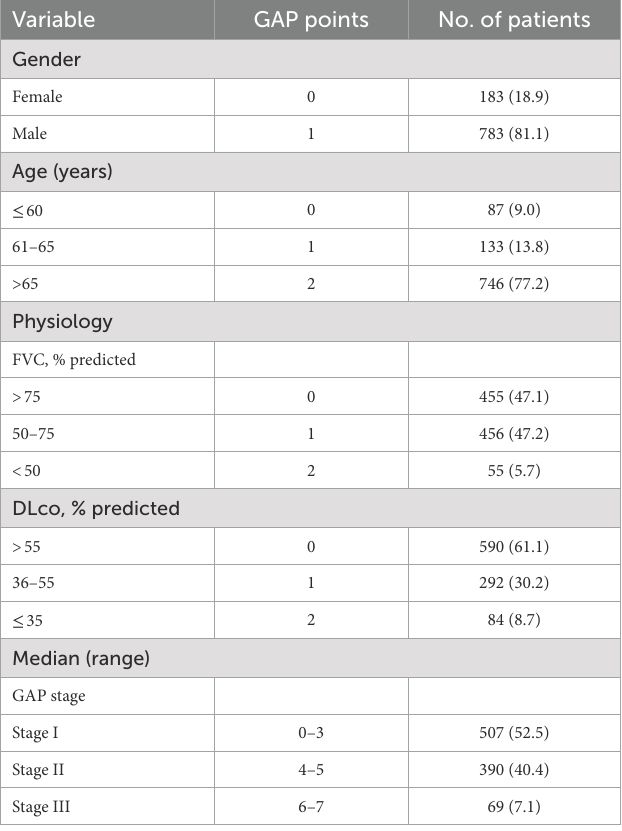
TABLE 1 Baseline clinical characteristics of the patients. Characteristics